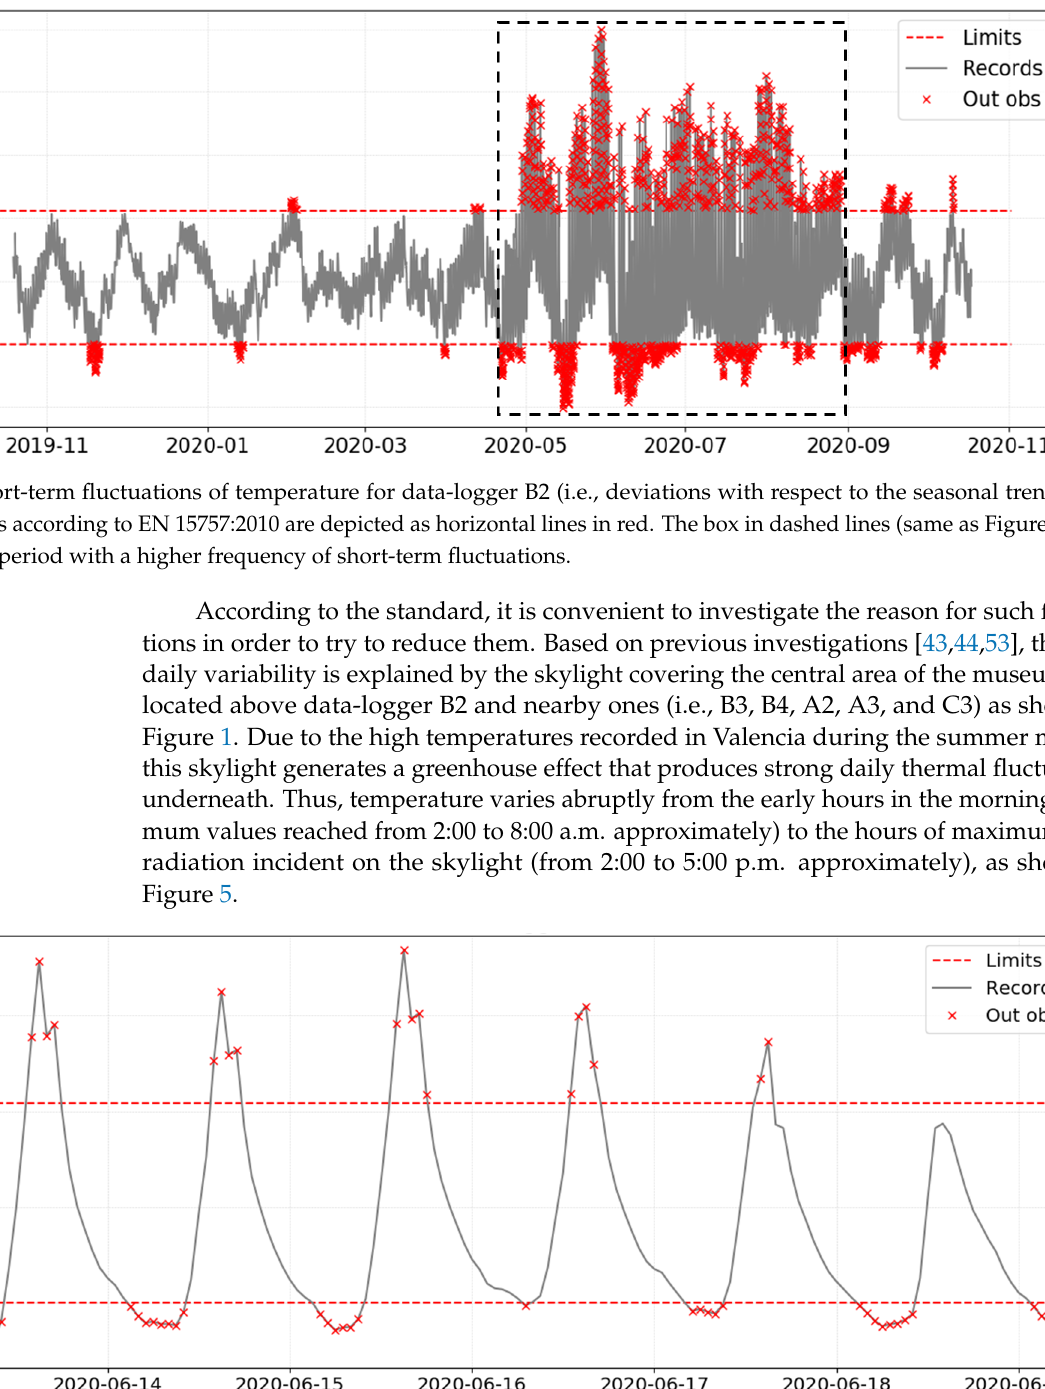
Figure 3. Evolution over time of temperatures recorded by data-logger B2. The seasonal trend is indicated as a black line. Security limits calculated according to EN 15757:2010 are depicted in blue. The box in dashed lines indicates the period with a higher frequency of short-term fluctuations, between April 20th and September 1st.